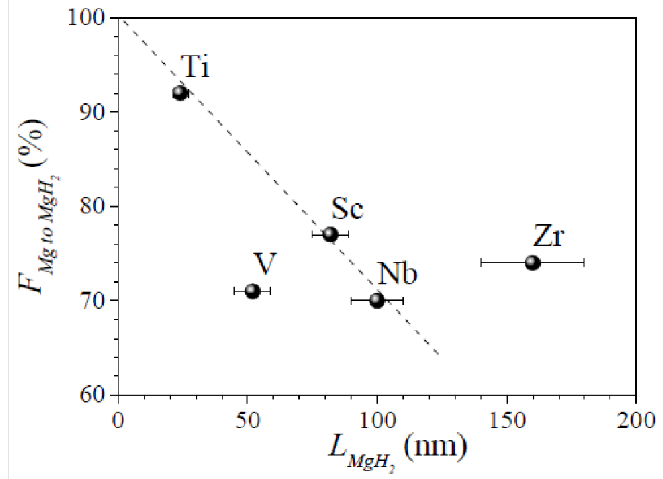
Figure 45. Dependence of the Mg to MgH 2 reacted fraction, F, on the MgH 2 crystallite size L MgH MgH 2 –ETMH x nanocomposites at the 20th absorption sweep. The dashed line is a guide to the eye. Reproduced with permission [37]. Copyright 2019, Royal Society of